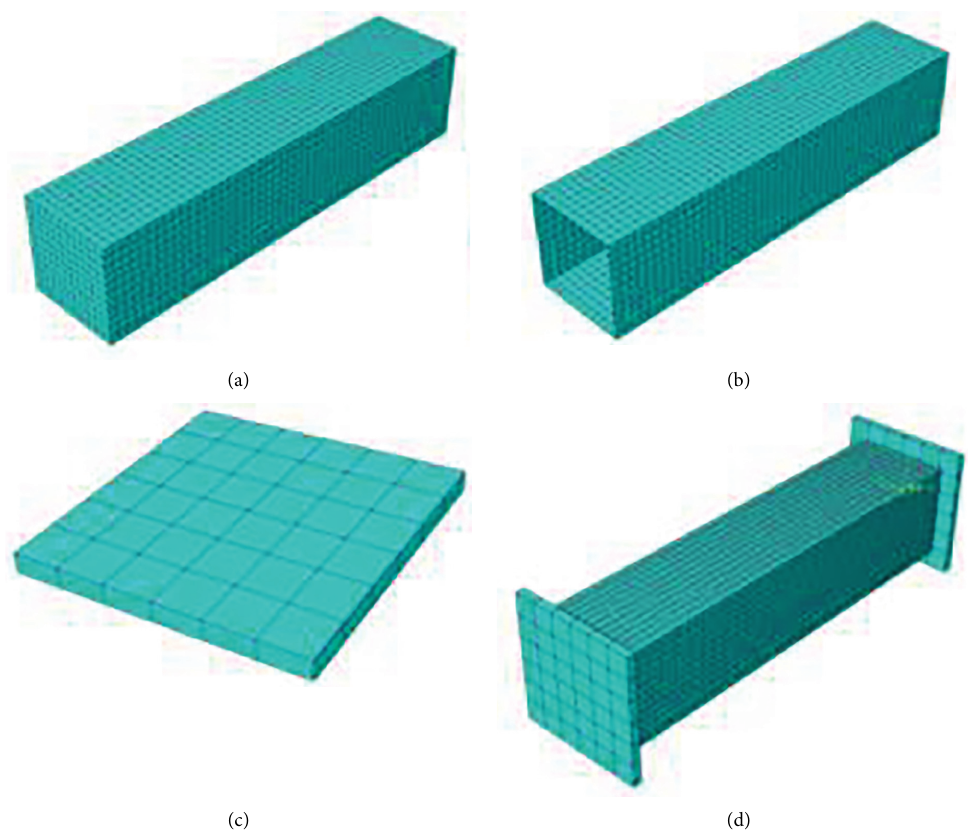
Figure 7: Model mesh subdivision. (a) Concrete. (b) Angle steel plate. (c) Cushion block. (d) Whole